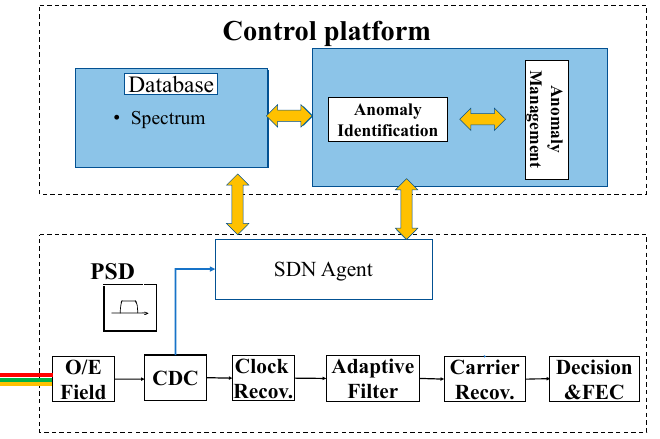
Figure 4. The overall architecture of the failure identification scheme in [12].